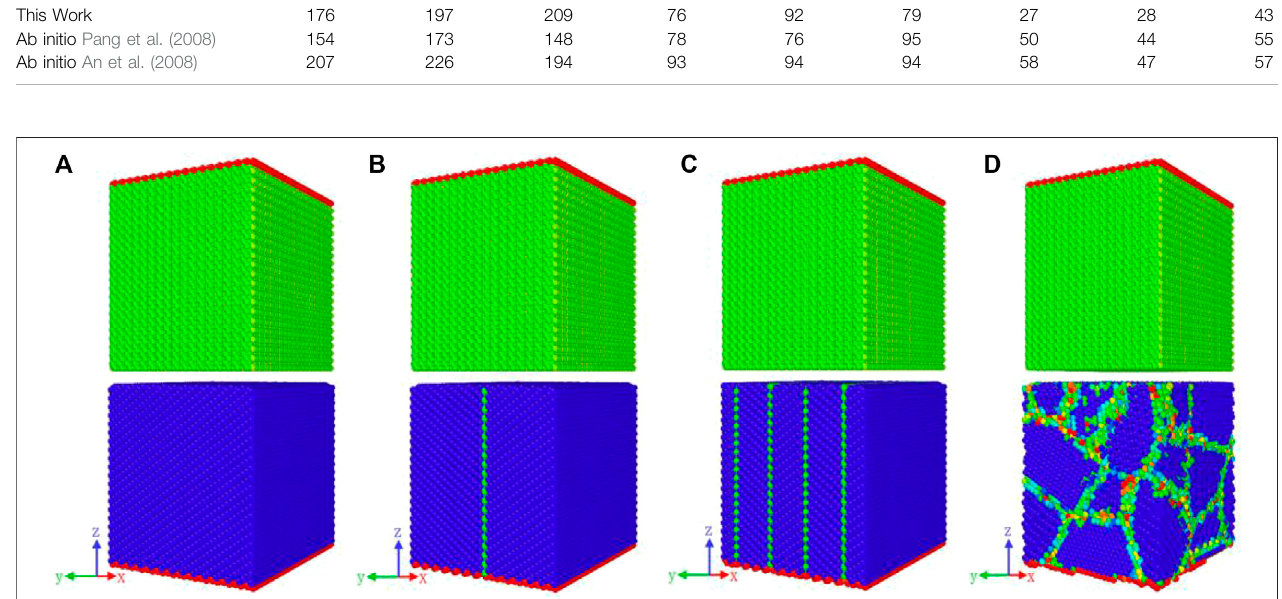
FIGURE 1 | Molecular models of the interface between Cu 3 Sn and Cu with different grain structures: (A) single-crystal Cu, (B) twin-crystal Cu with one twin grain boundary, (C) twin-crystal Cu with four twin grain boundaries, and (D) polycrystalline Cu.